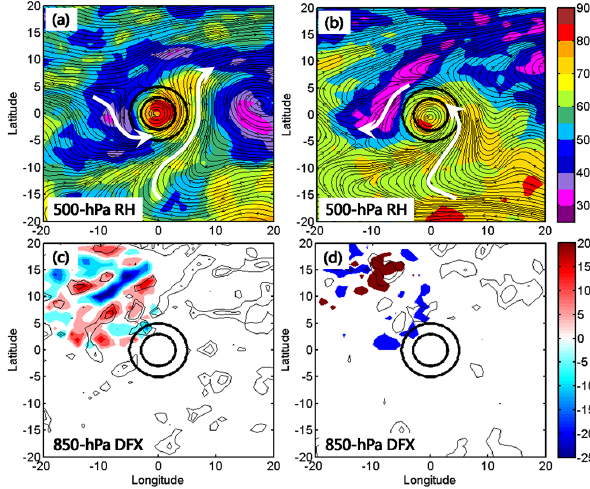
Figure 11. GFS-derived fields for the composites of RH (shad- ing, 5% intervals starting at 25%), streamlines at 500hPa (top) and DFX (shading, in 5Kms − 1 ) , vertical velocity (contours, − 0.25ms − 1 and − 0.5ms − 1 ) at 850hPa (bottom) for (left) weak- ening and (right) strengthening events confined to the west of 135 ◦ E at time t + 48 h . The solid white arrows in (a) and (b) high- light the mean streamlines in the western and eastern sides of TC. Two black solid circles are 3 ◦ - and 5 ◦ -radius circles centered on the